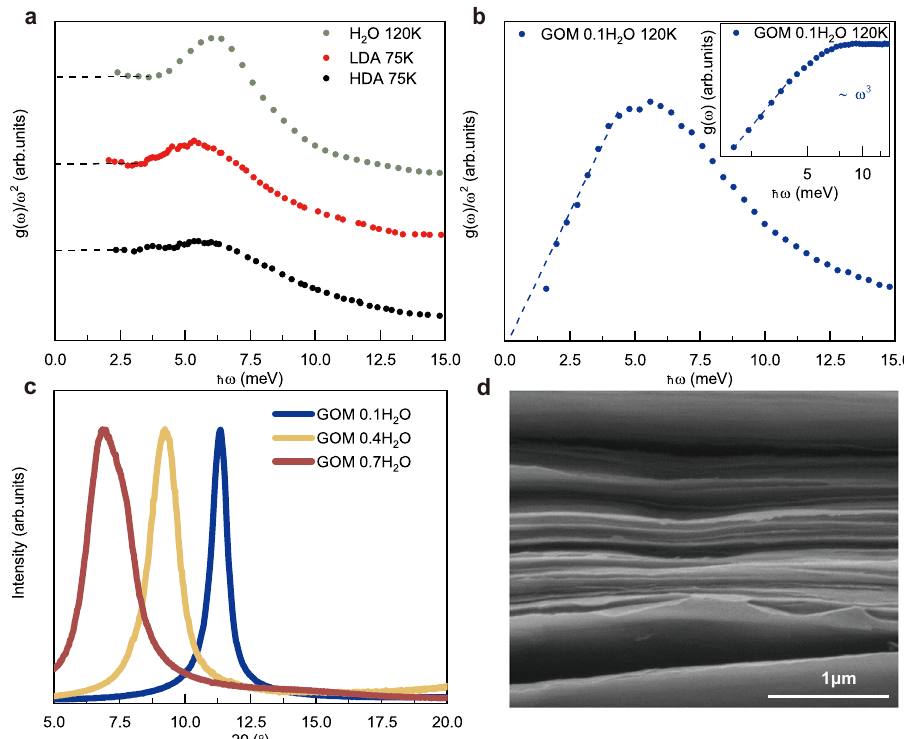
Fig. 2 The ω 3 scaling induced by the con fi nement of graphene oxide membrane(GOM). a The Debye normalized VDOS g ( ω )/ ω 2 for high density amorphous (HDA) ice, low density amorphous ice (LDA) obtained from ref. 48 and bulk crystalline ice measured in this work at 120K. The horizontal dashed lines indicate the Debye level for each sample. The curves have been manually shifted vertically for better presentation and the vertical axes has arbitrary units. b The experimental normalized VDOS g ( ω )/ ω 2 for the hydrated GOM sample at h = 0.1 g water/gram GOM. The dashed line indicates the low frequency ~ ω 3 scaling due to con fi nement. The inset shows the original VDOS data in log – log scale. The y- axes are presented in arbitrary units. c The XRD data of GOM sample with different hydration levels. d The scanning electron microscope (SEM) image of the GOM sample which highlights the fuzzy boundaries of the graphene oxide